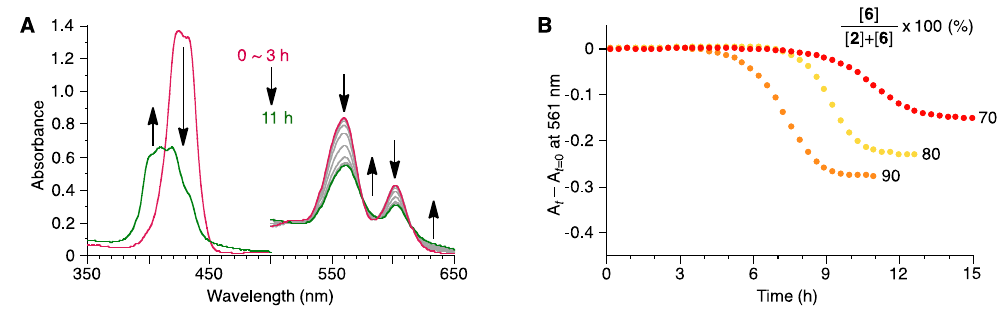
Figure 3. Kinetic studies of the self-assembly behavior of two-component 2 / 6 system. ( A ) Time-dependent absorption spectral changes of two-component 2 / 6 J aggregate: [ 2 ] + [ 6 ] = 50 μ M; [ 6 ]/{[ 2 ] + [ 6 ]} = 90%. ( B ) Time profile of change in the absorbance at 561 nm, a wavelength that is characteristic of the J aggregate: [ 2 ] + [ 6 ] = 50 μ M; [ 6 ]/{[ 2 ] + [ 6 ]} = 70, 80, and 90% as